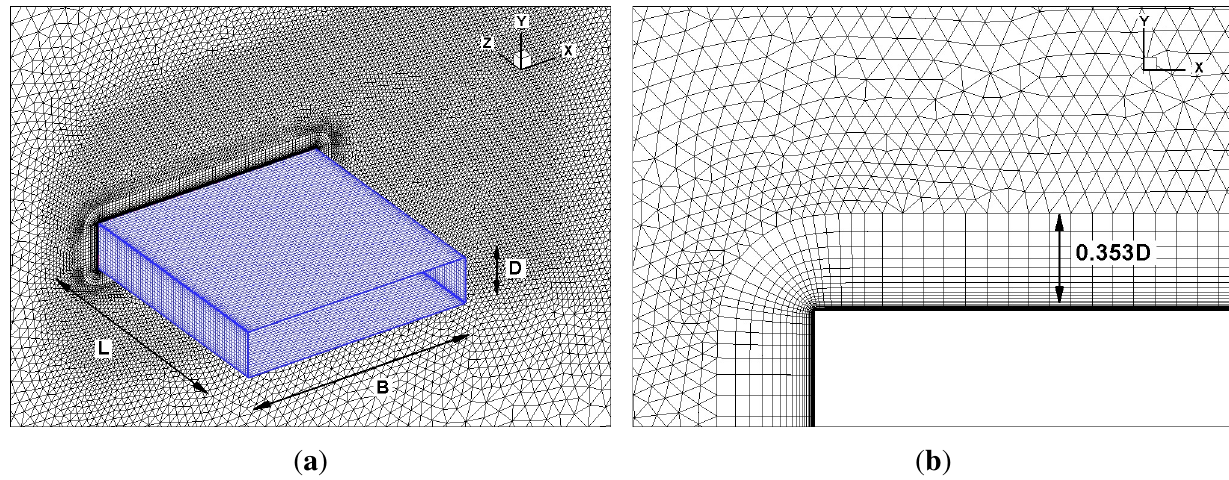
Figure 9. Three-dimensional hybrid mesh used in the DES calculations ( L 1 ) for the rectangular 5:1 cylinder: near body grid and wake refinement ( a ); close-up of the structured part of the mesh ( b